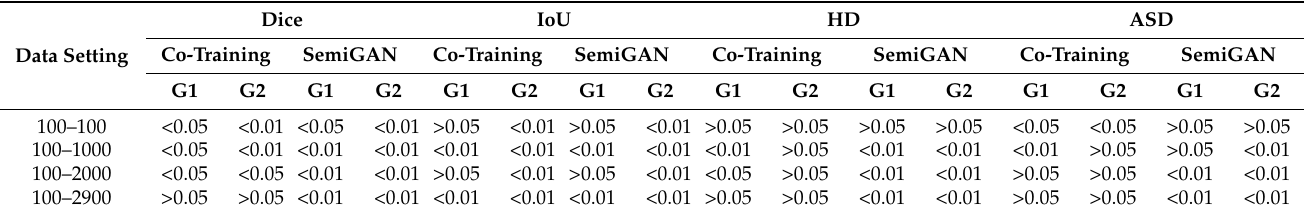
Table 11. Paired t -test between Diff-CoGAN, co-training, and semi-GAN using the Hippocampus dataset. In general, the p -values for the four metrics are less than 0.5; thus, we can accept the alternative hypothesis that there are statistically significant